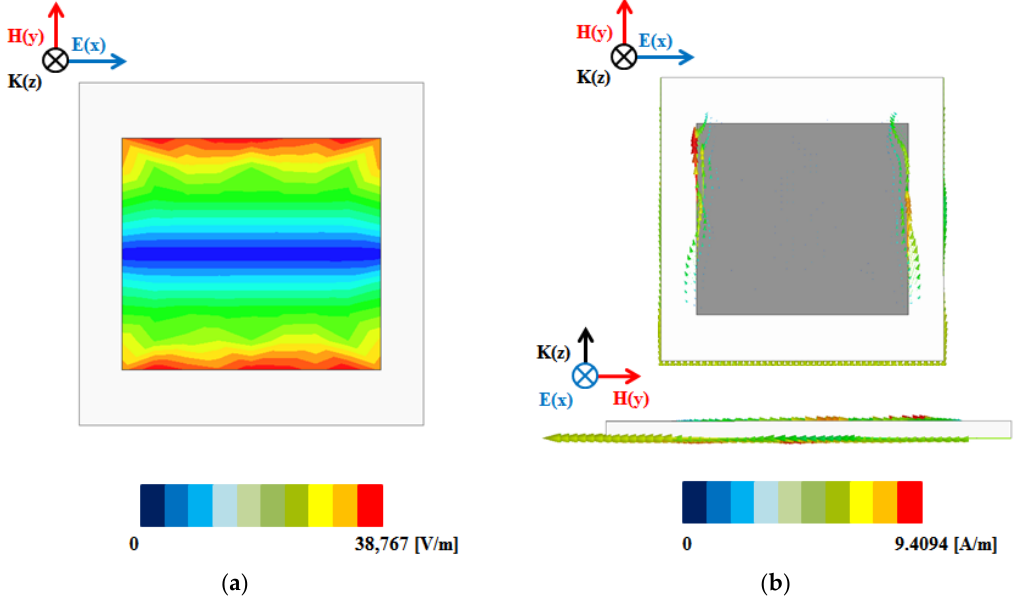
Figure 3. ( a ) Simulation of unit cell electric field distribution; ( b ) Vector current density.